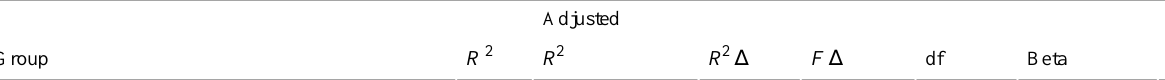
Table 4. Summary of mediational analyses for the adolescent